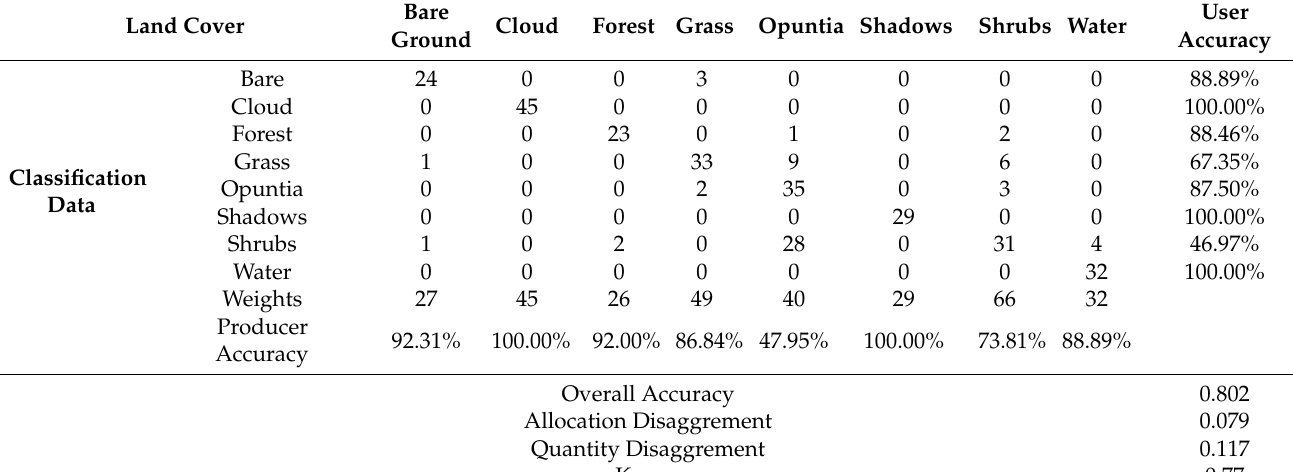
Table 6. Confusion matrix for model 2.a user’s and producer accuracy. The overall weighted accuracy is 0.89 ± 0.031. Land